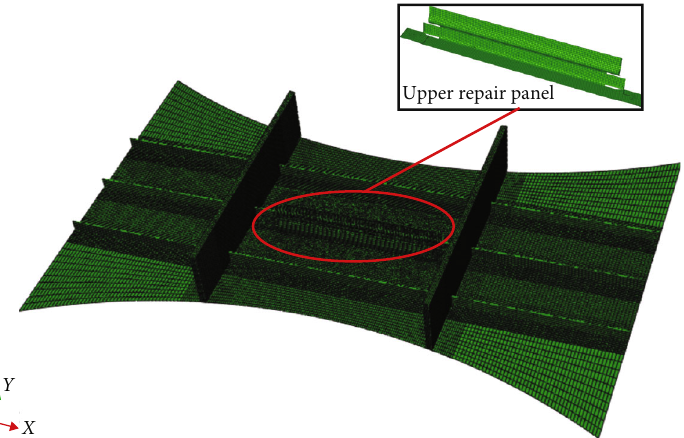
Figure 5: Repaired panel ’ s mesh model (upper